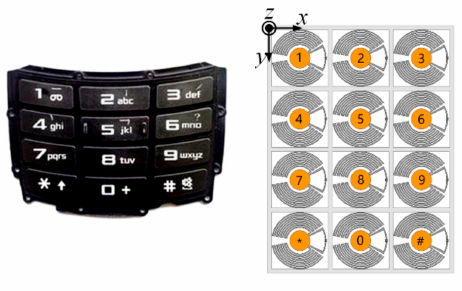
Figure 9. Arrangement of the proposed tag